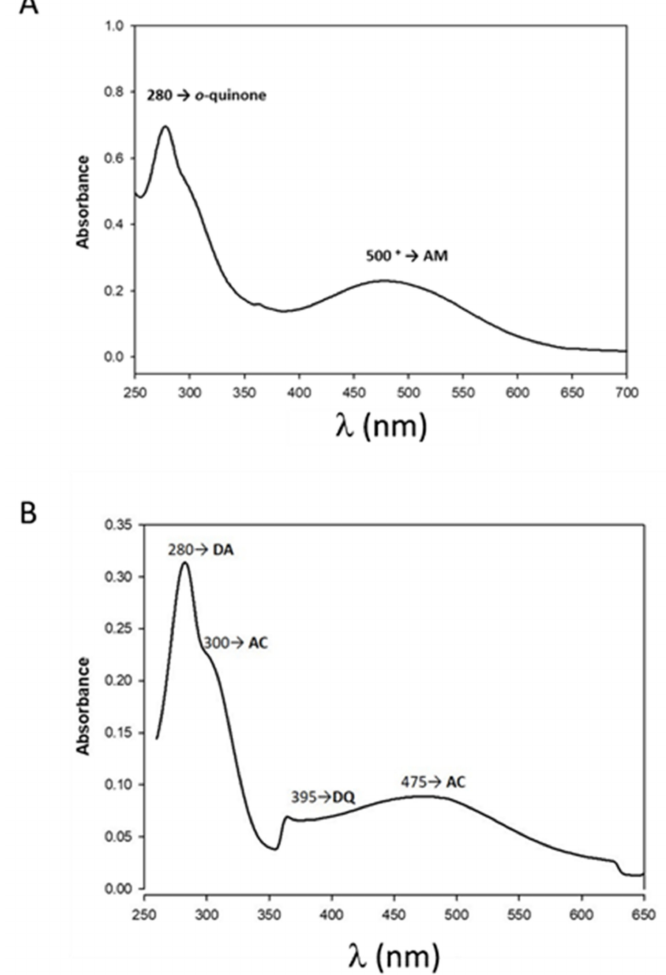
Figure 4. ( A ) UV-visible spectrum of G 10 C 10 N 10 sol. ( B ) UV-visible spectrum of G 10 D 20 N 10 sol. The samples were taken directly from the batch at elevated temperature, hence in the sol state. The nomenclature of the chemical species is the same as in Scheme 2 and AM is the abbreviation for Michael